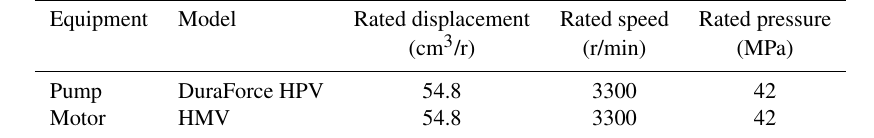
Table 4. Parameters of variable displacement pump and fixed displacement motor.